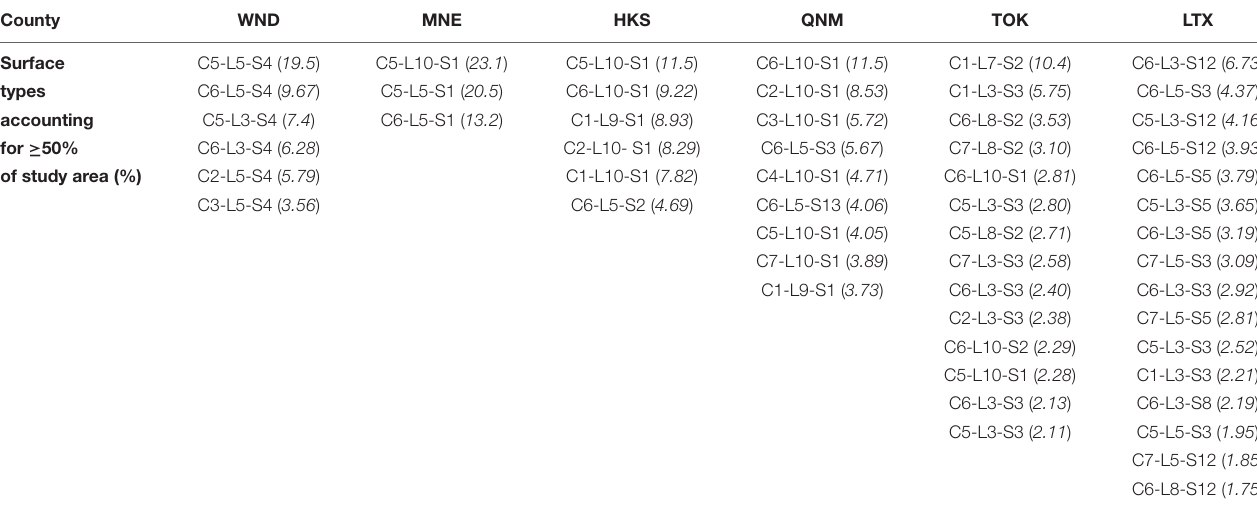
TABLE 5 | Surface types covering at least 50% of the respective study area.